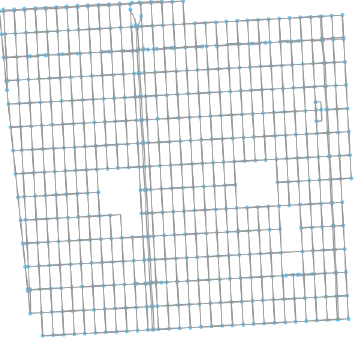
Figure 2. Urban setting used in this work. Data obtained from Open Street Map